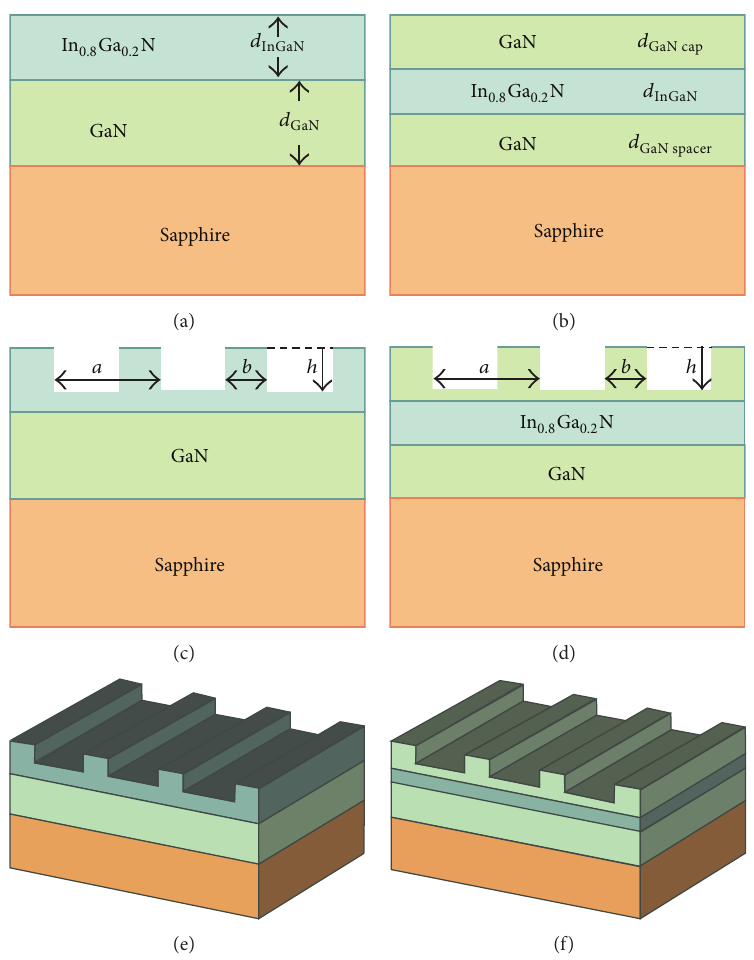
Figure 1: (a) Initial InGaN PC structure studied in [27]. (b) Layer structure of the modified solar cell structure incorporating the GaN cap layer. (c) Cross-sectional etch geometry for the initial structure in (a). (d) Cross-sectional etch geometry for the modified structure in (b). (e) 3D view for the initial structure in (a). (f) 3D view for the modified structure in